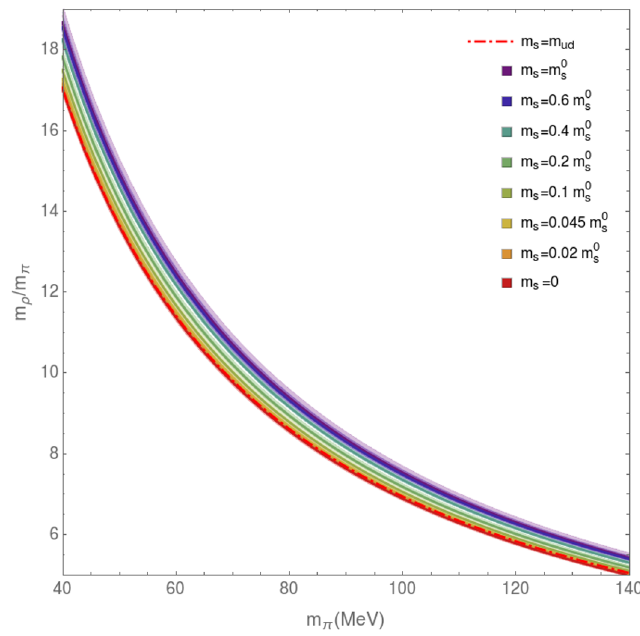
Figure 27 . m (cid:26) =m (cid:25) ratio as a function of m (cid:25) for the m s = k and m s = m ud trajectories continued towards lighter pion masses.